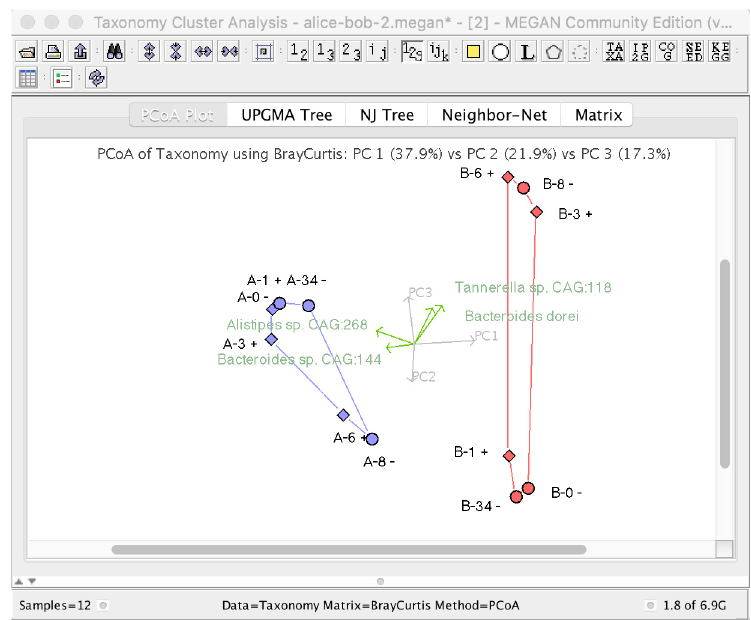
Fig 4. A PCoA analysis of 12 human gut samples [16] computed using species-level profiles and Bray-Curtis distances. Samples are labeled by subject pseudonym, day 0 – 34 and whether antibiotics were taken (+) or not (-) on the given day. For both subjects, the plot clearly shows that the taxonomic profiles move further and further away from the original during the course of antibiotics, but then return back close to the original at the end of the study. The top five bi-vectors are also shown, labeled by species name.